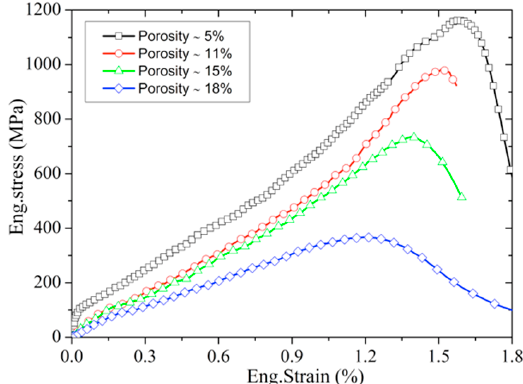
Figure 7. Typical eng.stress–eng.strain curves of poled PZT95/5 ceramics with different porosities at the strain rate of ≈ 300 s − 1 .